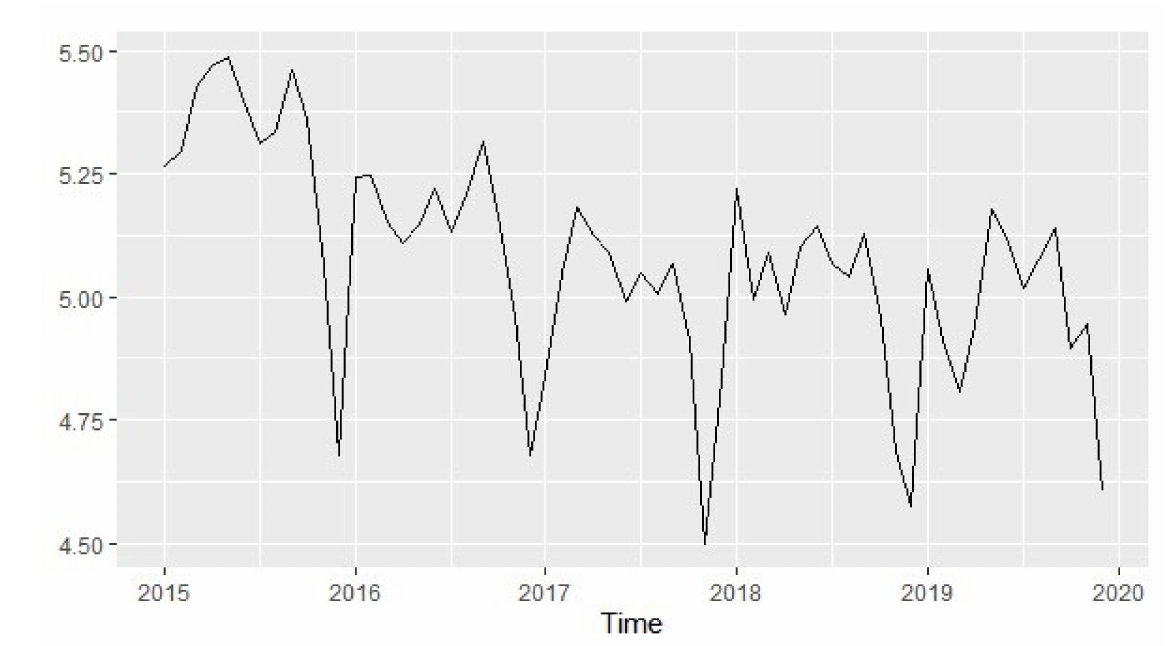
Figure 5. Box Cox transformed graph to stabilize the variance.